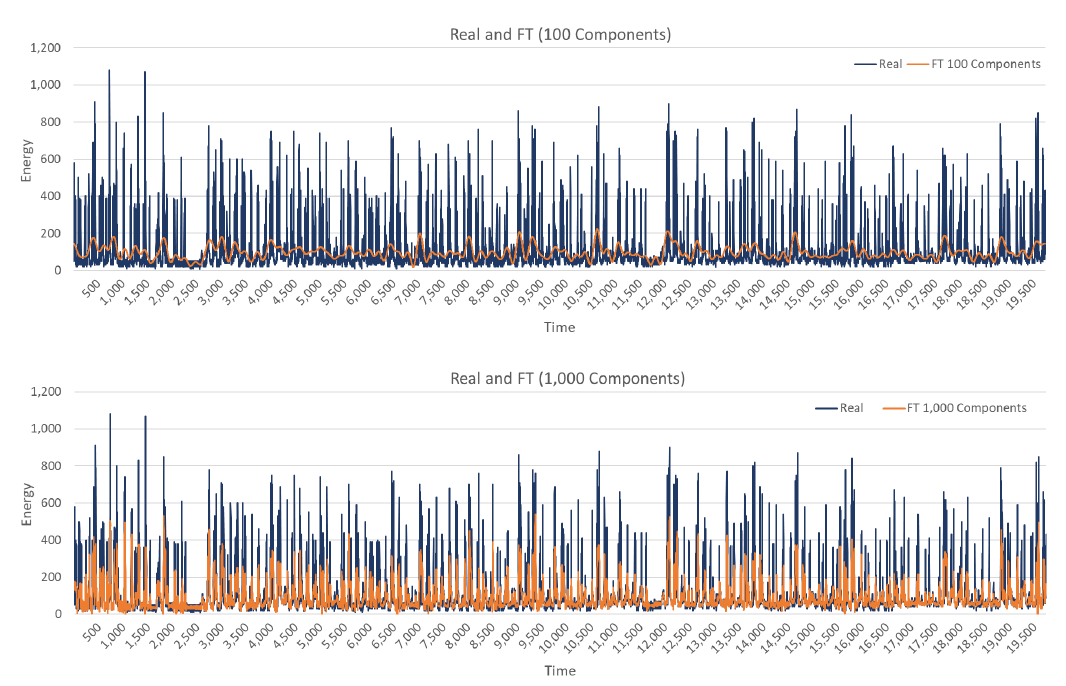
Figure 8. The results of Fourier transform with 1, 10, 100, and 1000 components (UCI data